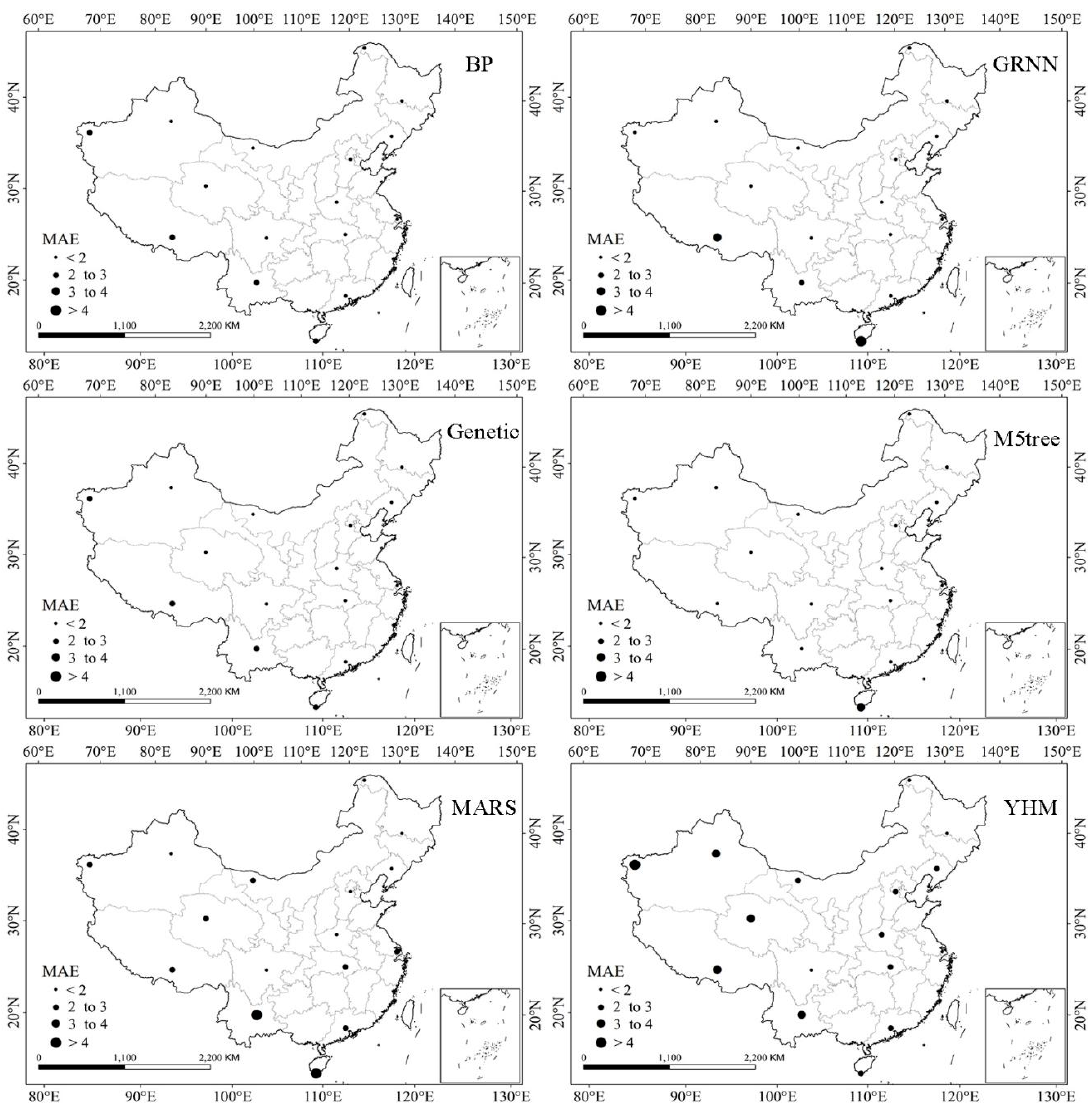
Figure 6. Spatial variation of the mean absolute bias error ( MAE) for the six DHI models.